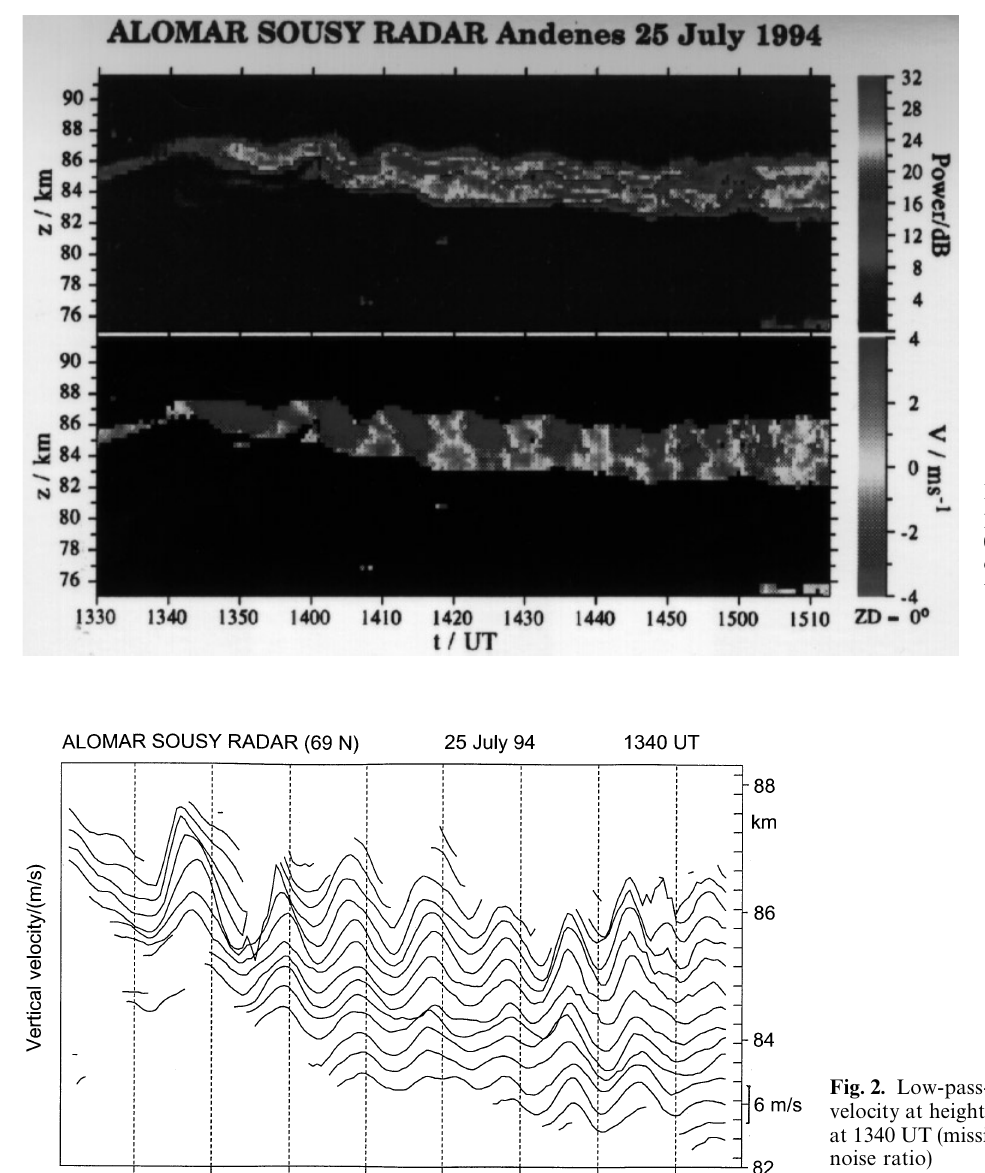
Fig. 2. Low-pass-filtered time series of the vertical velocity at heights between 82 and 88 km, starting at 1340 UT (missing data are due to low signal-to- noise